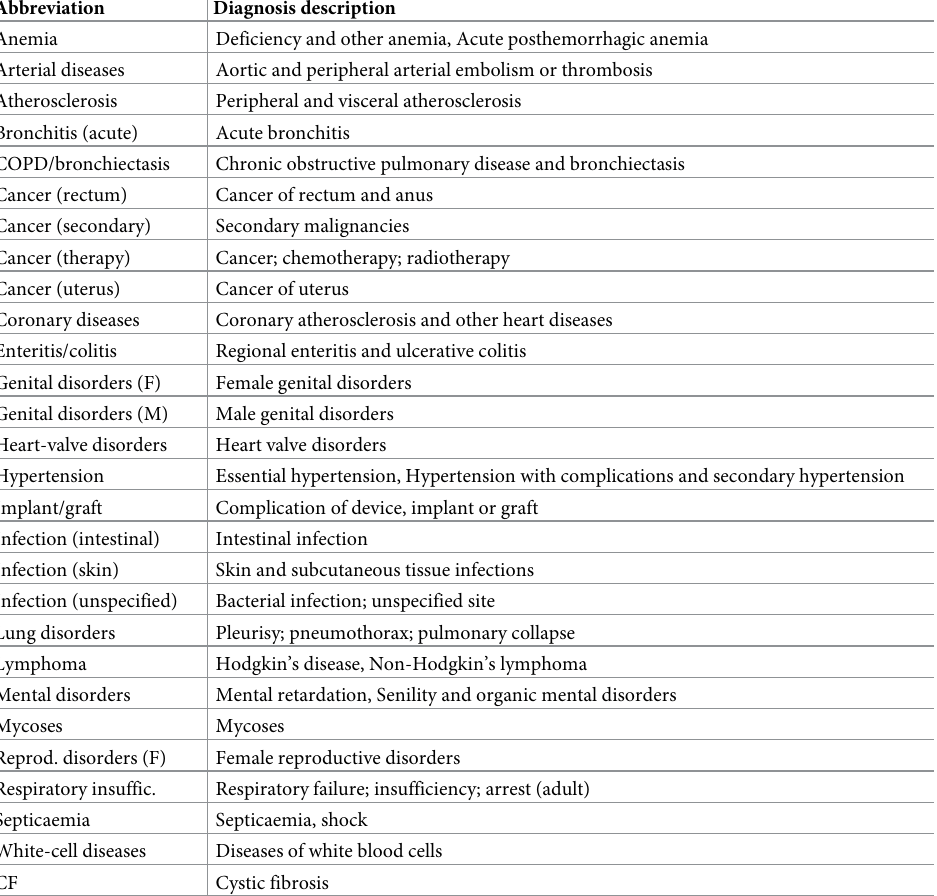
Table 2. Pre-existing morbid conditions classified according to the SHMI diagnosis codes and abbreviations used throughout the